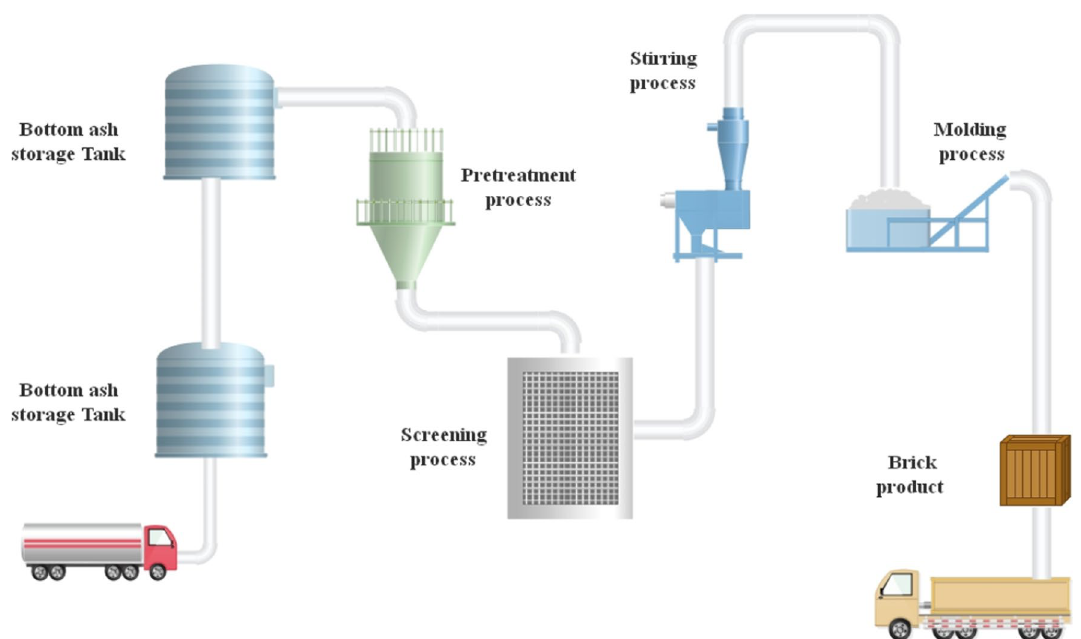
Fig. 2 Small brick production subsystem in Scenario